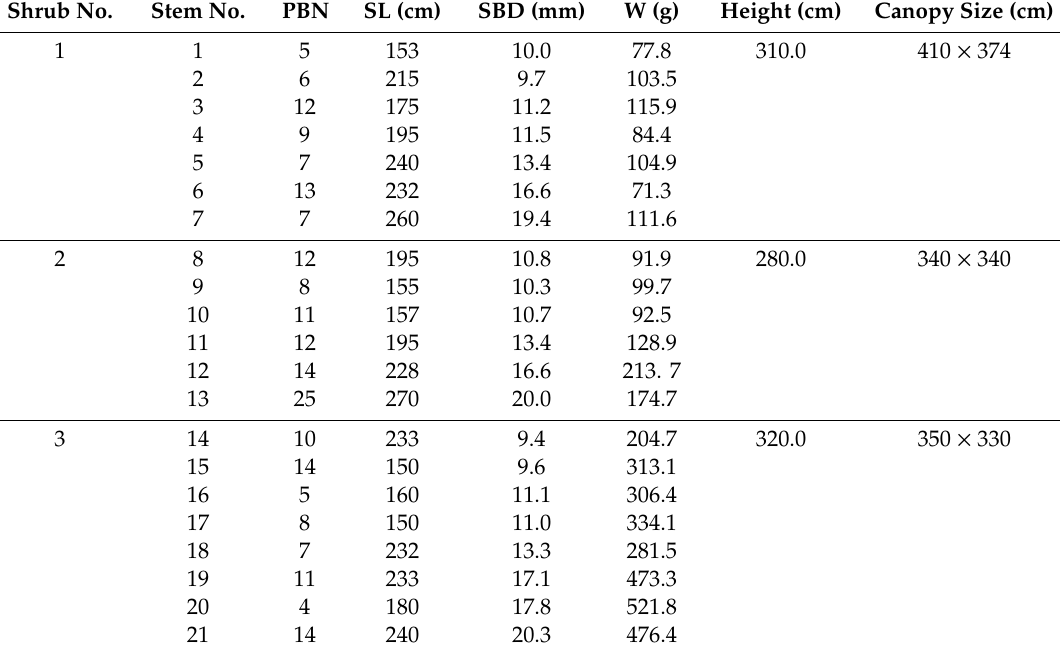
Table 1. Morphological traits of the twenty-one stems used for the sap flow (SF) measurements for Caragana korshinskii Kom. Shrub No. Stem No. PBN SL (cm) SBD (mm) W (g) Height (cm) Canopy Size